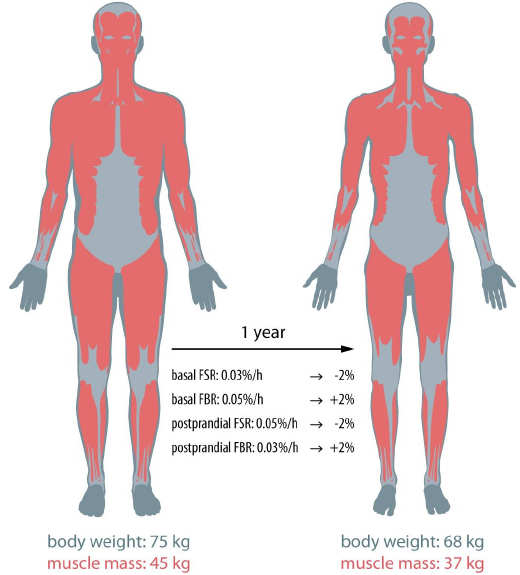
Table 1. Muscle protein synthesis and breakdown rates in cancer